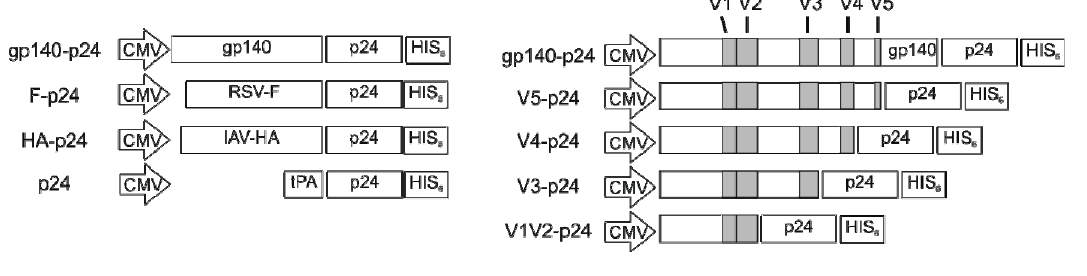
Figure 1. Maps of expression cassettes.